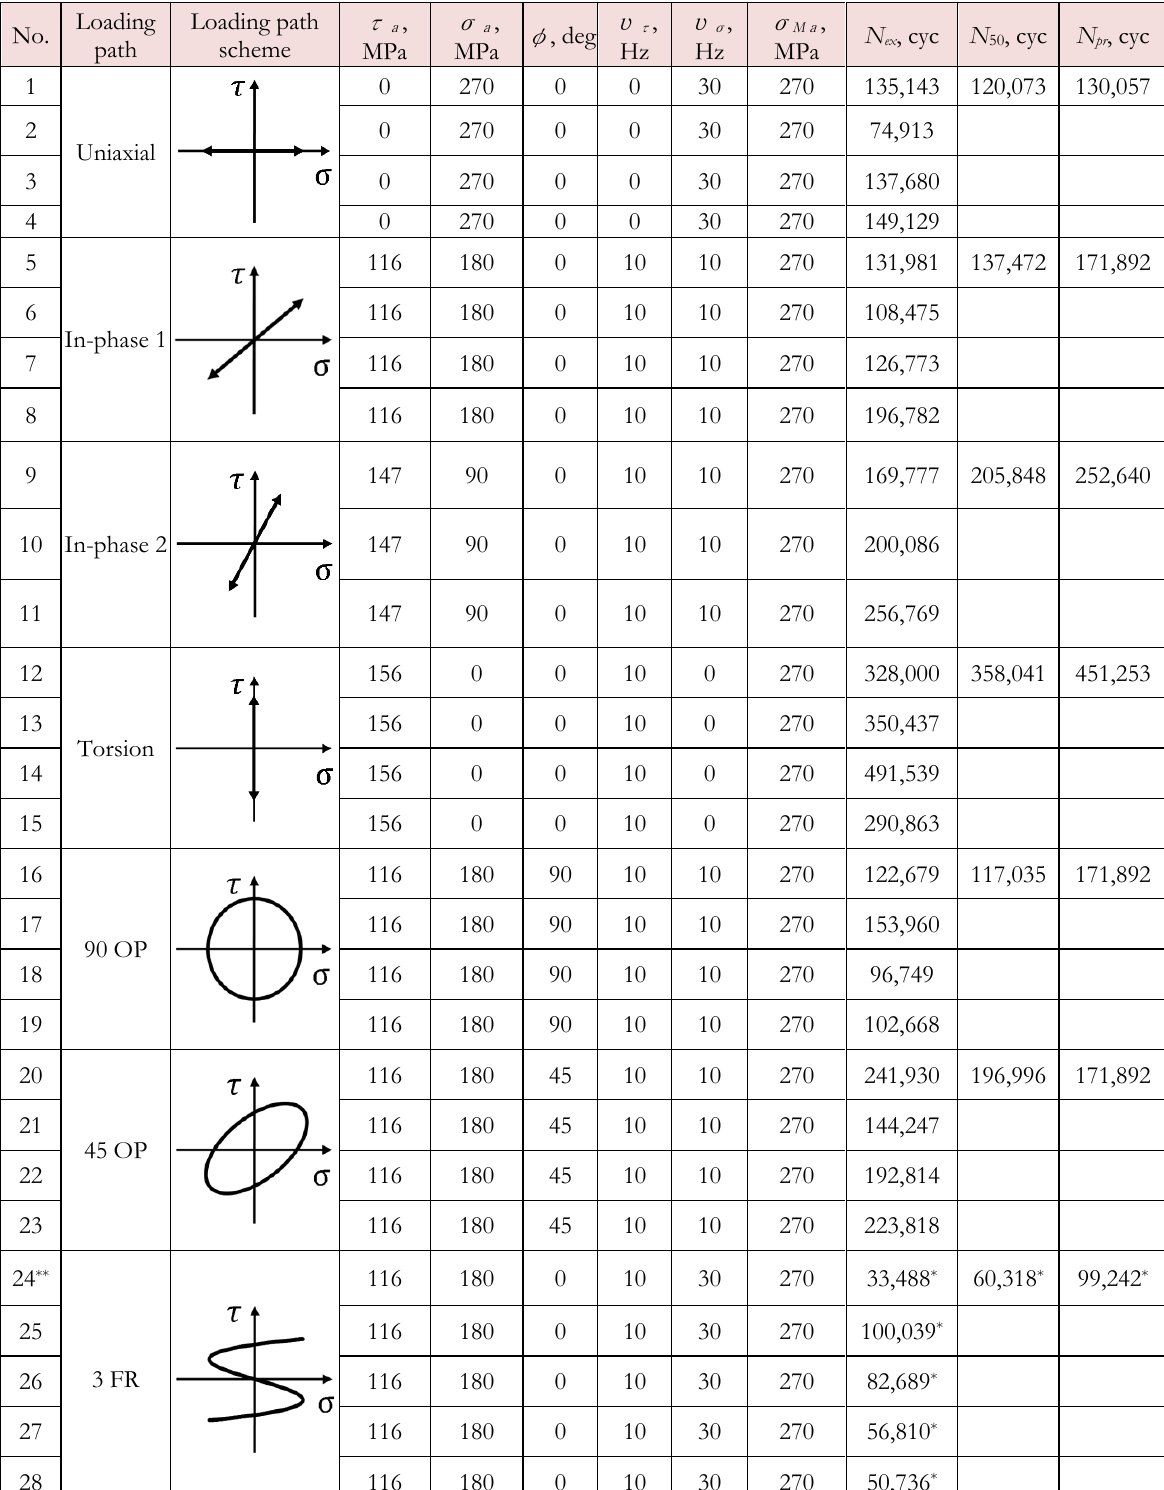
Table 2: Summary of fatigue tests. (For loadings 24-28, cycles were counted in a tangential mode; Test result No. 24 is outside the ±2- factor